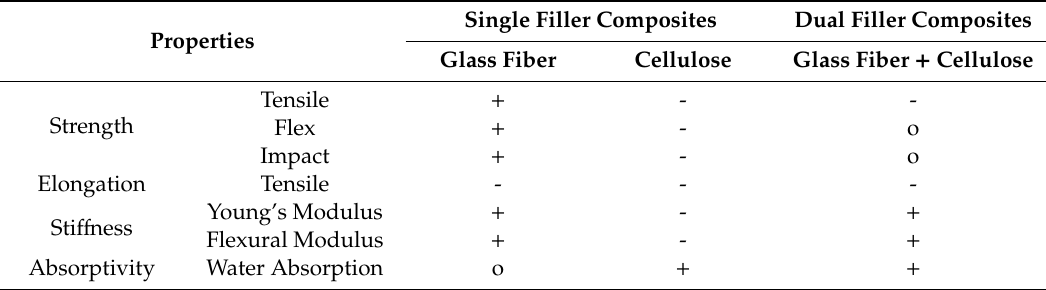
Table 2. Details of mechanical properties for PP, PA6, and hybrid fibers (cellulose and glass fibers) composites. Samples containing the combination of one or both fibers were compared to their unfilled control, lacking the hybrid fibers. Boxes labelled ( + ) exhibited property improvement, white boxes with (o) experienced no significant property change, and boxes (-) experienced property